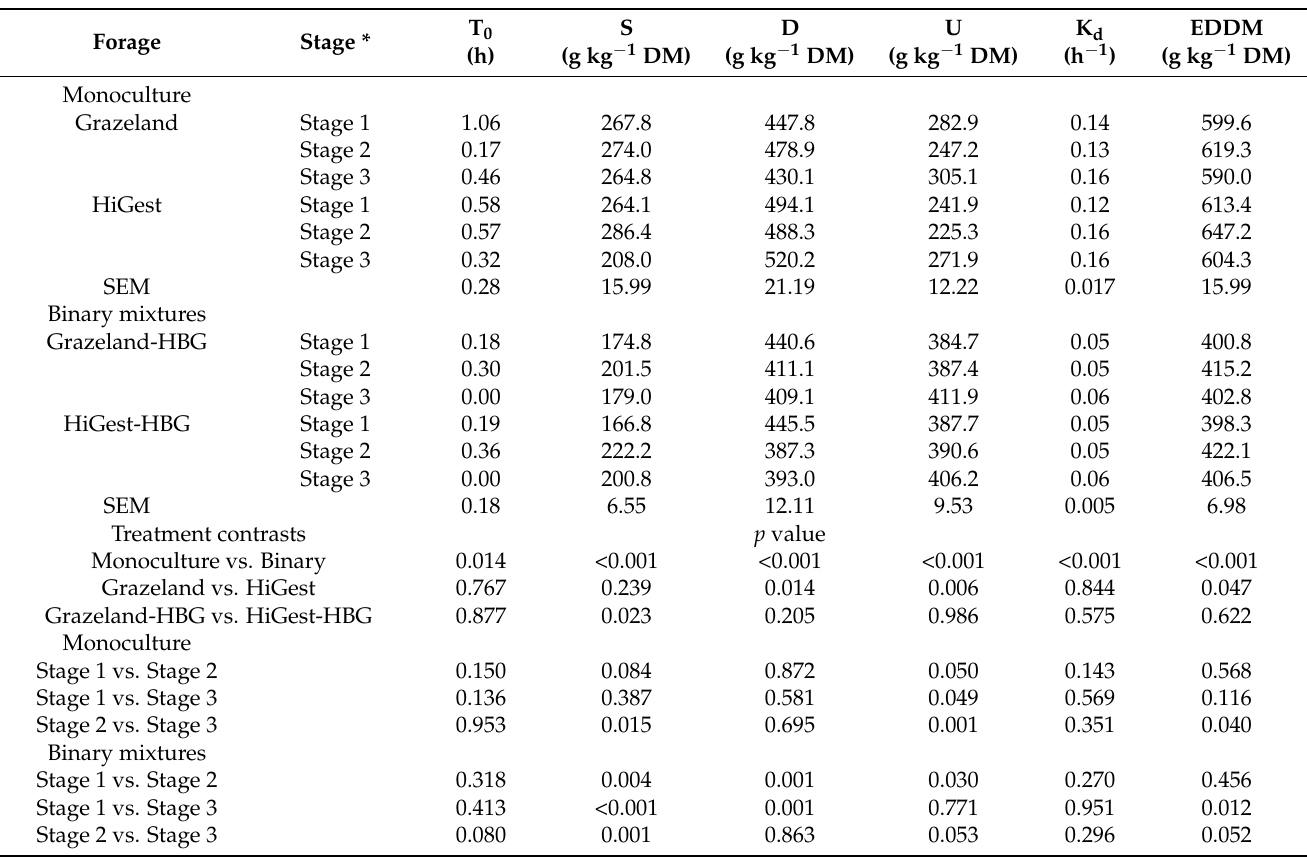
Table 2. Effects of cultivar, maturity, and their interaction on in situ rumen degradation kinetics of DM of alfalfa cultivars in monoculture and in binary mixtures with AC Success hybrid bromegrass (HBG) in Saskatoon, Saskatchewan